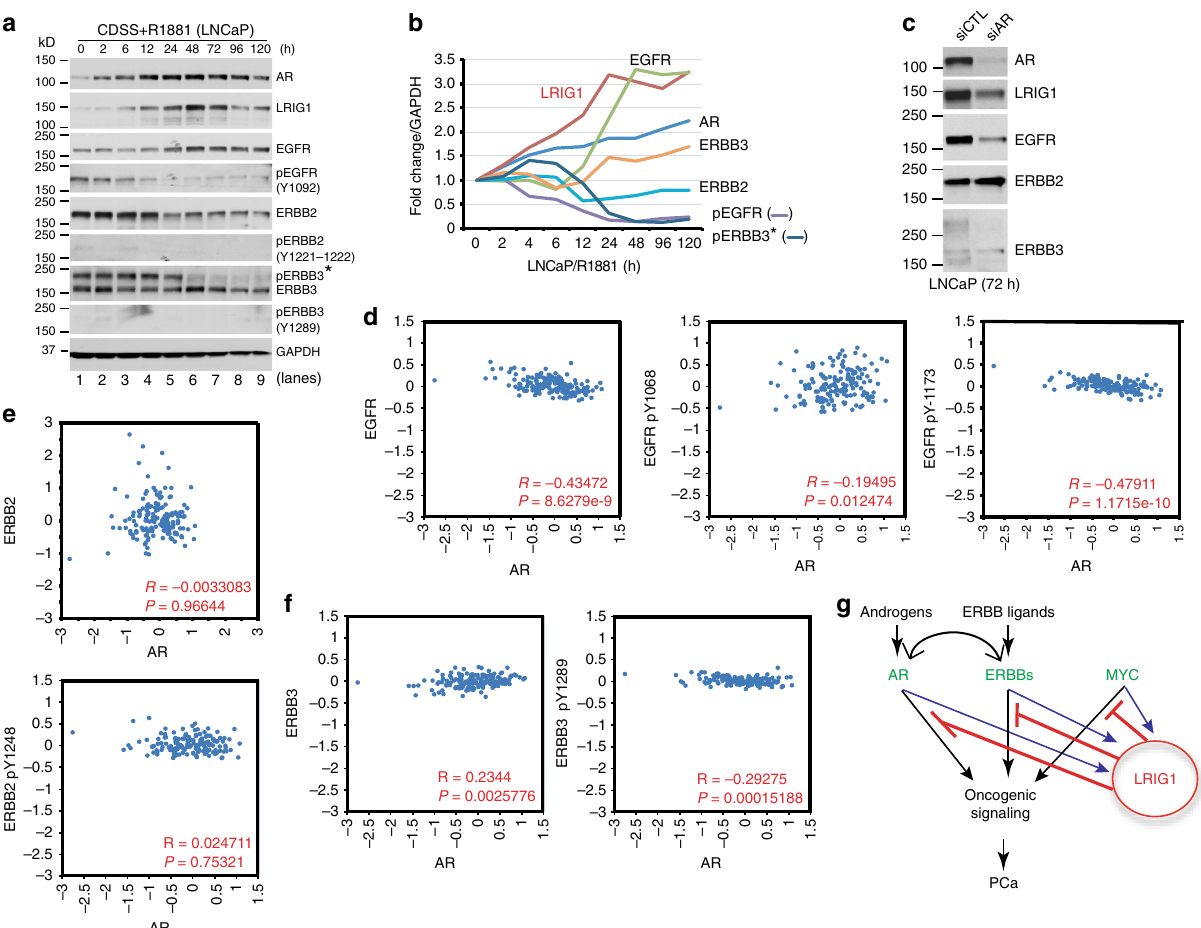
Fig. 10 AR induces LRIG1 to curb ERBB signaling: a model. a , b R1881-induced AR upregulation is accompanied by increased LRIG1 and dynamic downregulation of (p)ERBB members in LNCaP cells. LNCaP cells cultured in CDSS (48 h) were treated with R1881 (0.1 nM) for up to 120 h (R1881 was replenished every 24 h) and whole cell lysate (80 μ g/lane) was used in WB for the molecules indicated. Protein bands were scanned by densitometry and shown in b is the quanti fi cation of average ( n = 2) protein levels of AR, LRIG1, and (p)ERBB members normalized to GAPDH levels at time 0 (1.0). Note that pERBB2 (Y1221-1222) and pERBB3 (Y1289) bands were too faint to scan. pERBB3* was the (putatively) phosphorylated ERBB3 band detected by the mouse mAb against ERBB3 (Millipore 05-390; see Supplementary Table 1). As can be seen, AR induction was accompanied by increased protein levels of AR, LRIG1, EGFR, ERBB3 but decreased levels of pEGFR, ERBB2, and pERBB3. c AR knockdown reduces LRIG1 and EGFR in LNCaP cells. LNCaP cells were treated by AR-targeting siRNAs (10 nM), and whole cell lysate used in WB for the molecules indicated. The results are representative of 2 independent experiments. d – f Potential relationship between AR and (p)ERBB protein levels in the human PCa TCPA database (see Text and Methods). The correlation coef fi cients (R values) and P-values were determined by linear regression analyses. g A model depicting that LRIG1 is feedback induced by three major signaling pathways in PCa, i.e., AR, c-MYC, and ERBBs, to neutralize/antagonize their oncogenic activities. The model also depicts cross-regulatory relationship between AR and ERBBs. *Source data for Fig. 10 (representative gel images) are provided as a Source Data fi